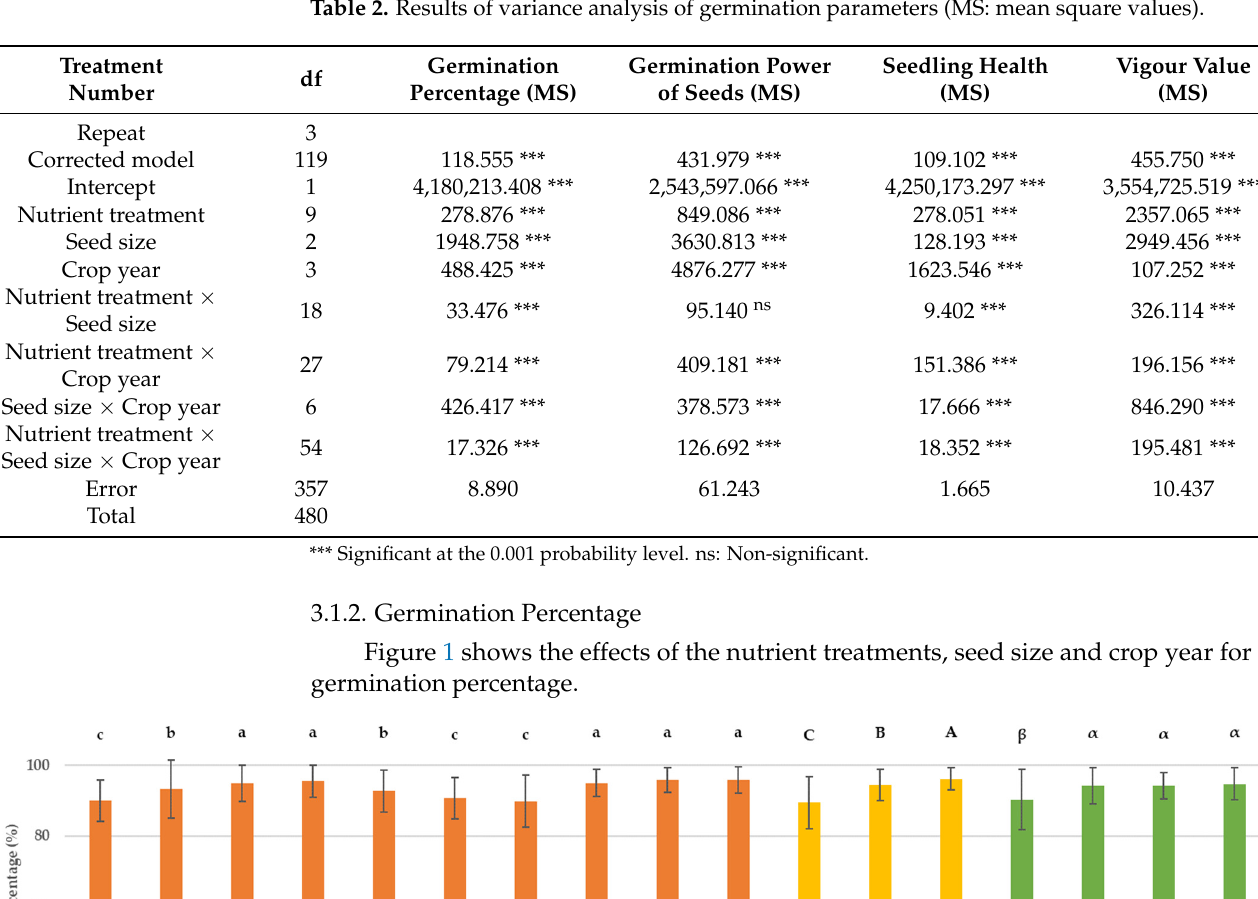
Table 2. Results of variance analysis of germination parameters (MS: mean square values).